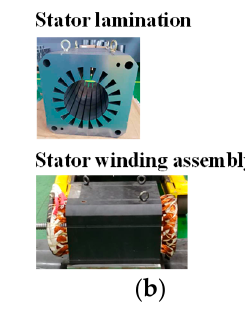
Figure 18. Prototype of the final design: ( a ) rotor, and ( b ) stator.